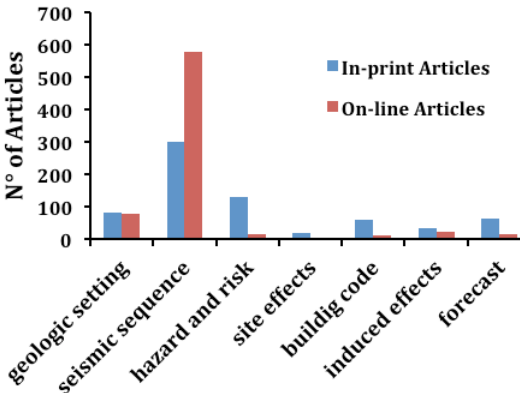
Figure !2. The WHAT in the Media: assessing the in- depth scientific coverage.